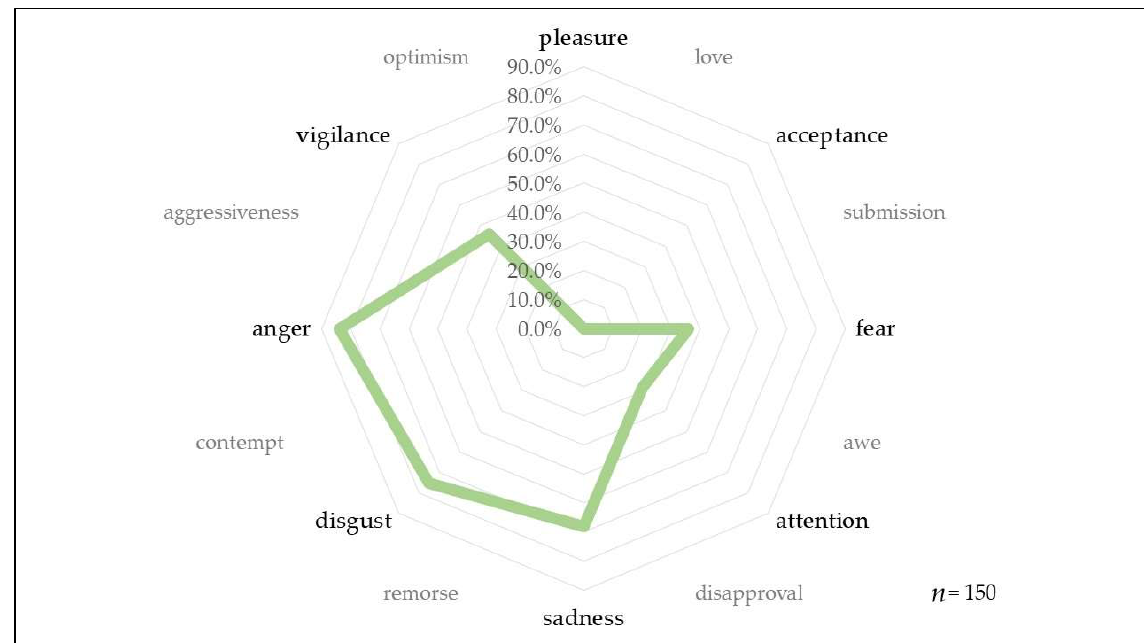
Figure 9. Extent of very strong emotional reactions of animal welfare activists ( n = 150).